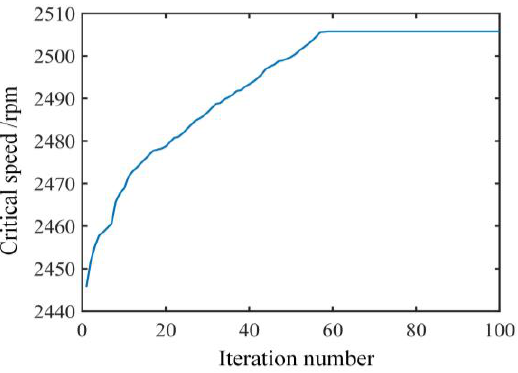
Figure 15. The convergence curve for the optimization of the first-order critical speed. Table 4. The ranges of the critical speeds calculated by different